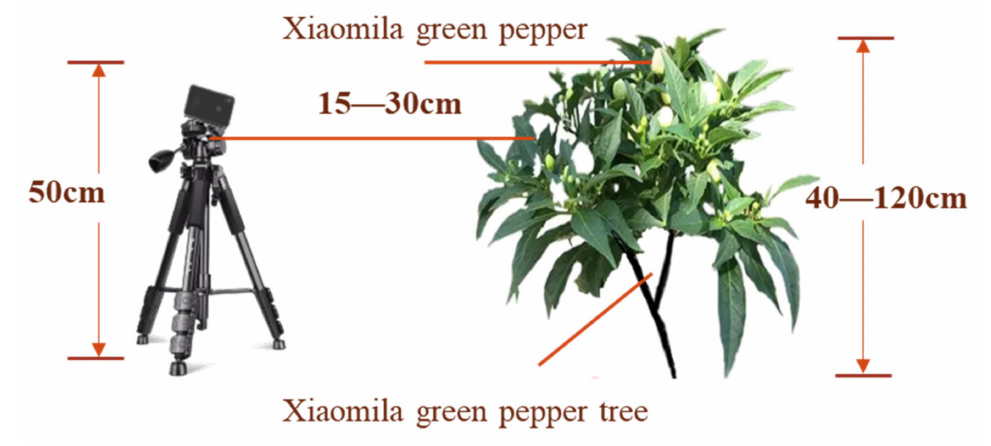
Figure 1. Methods of image